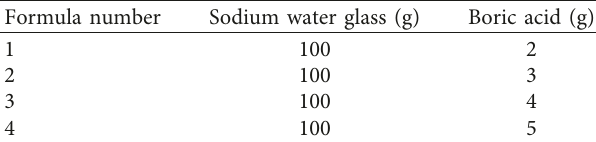
Table 1: Experimental formulas of different boric acid content.